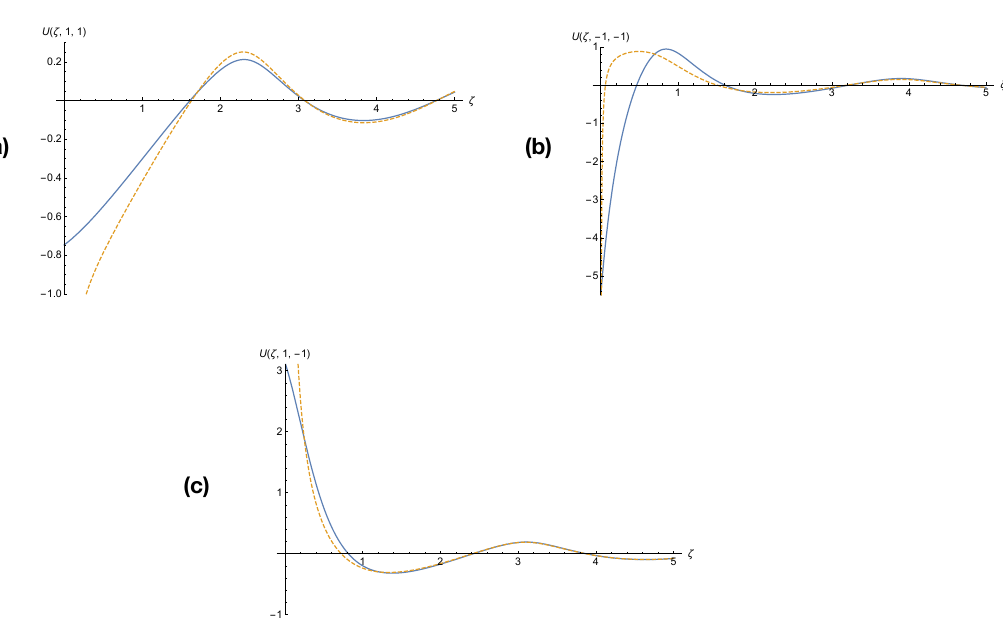
) (in units of the Fermi energy) between im- Figure 6: Effective interaction U ( z , γ , γ 1 2 purities, solid lines exact interaction given by Eq. (112) and dashed lines asymptotic large distance approximation Eq. (113). Shown in (a), (b) and (c) impurities with ) = ( 1,1 ) , ( − 1, − 1 ) and ( 1, − 1 ) interactions strengths ( γ , γ 1 2